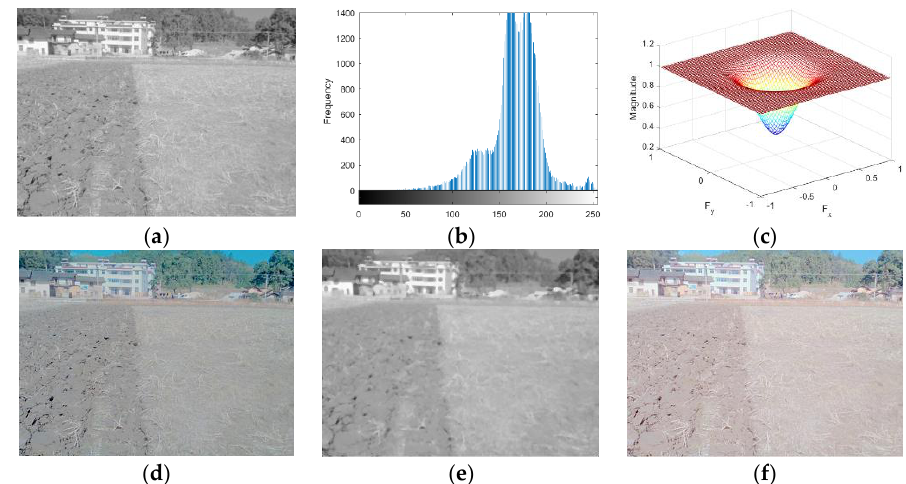
Figure 11. The process of the strong-light-intensity image using the homomorphic filtering algorithm: ( a ) grayscale; ( b ) grayscale histogram; ( c ) frequency response of the high-pass filter; ( d ) Butterworth high-pass filtering; ( e ) median filtering; ( f ) homomorphic filtering.